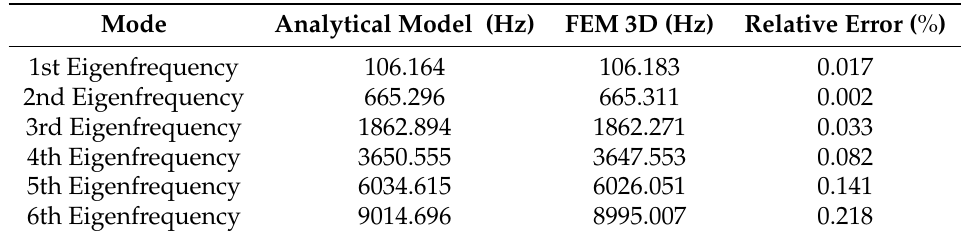
Table 2. First six modes of vibration calculated using analytical model based on Equation (3) and 3D FEM (Finite Element Model) using the COMSOL